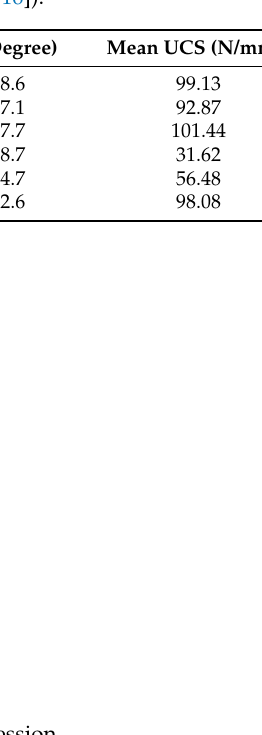
Table 10. Mechanical properties of sandstone (after [116]).